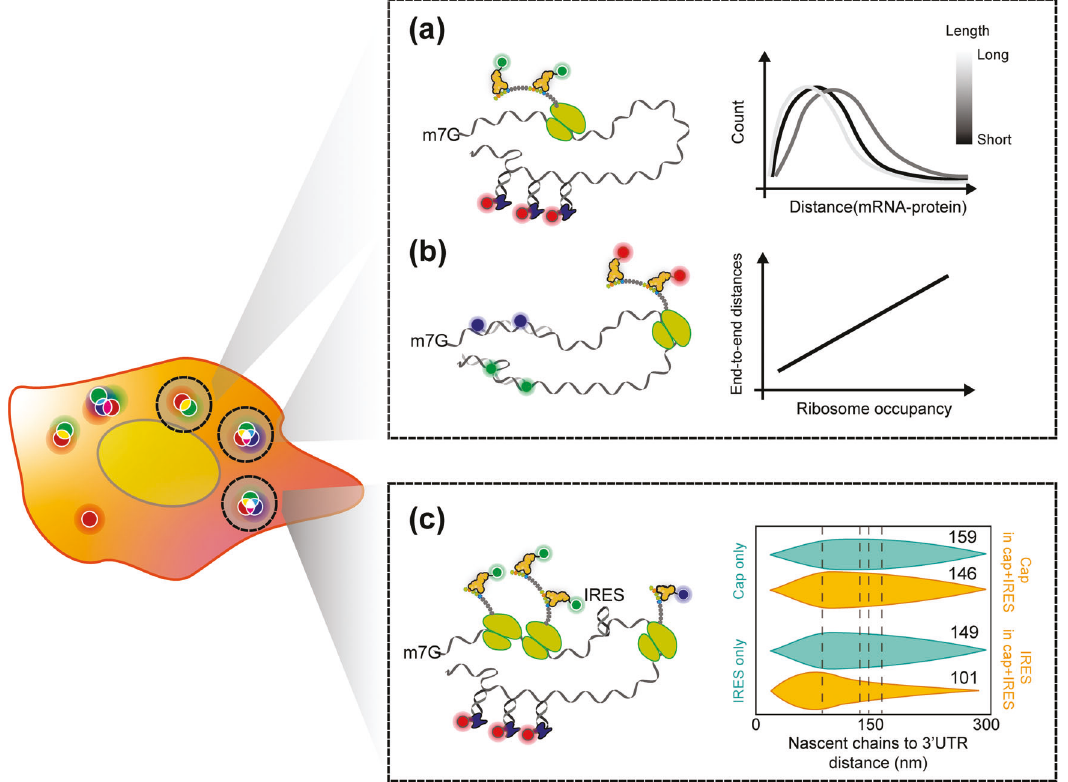
Fig. 3 mRNA circularization in cells. Schematic representing nontranslating or translating mRNA and the measurement of its end-to-end distance in a cell ( fi xed or live). a The distance between the nascent epitope and the PP7 stem ‒ loop indicates the compactness of the translating mRNP. b Direct end-to-end distance measurement of mRNA during translation depending on the translation state through the utilization of a smFISH probe in a fi xed cell. As ribosome occupancy increases, the distance between the two ends also increases. c End-to-end distance measurement of mRNA during cap or IRES translation (emerald) or both (orange). Cap translation leads to a longer distance than IRES translation resulting from ribosome